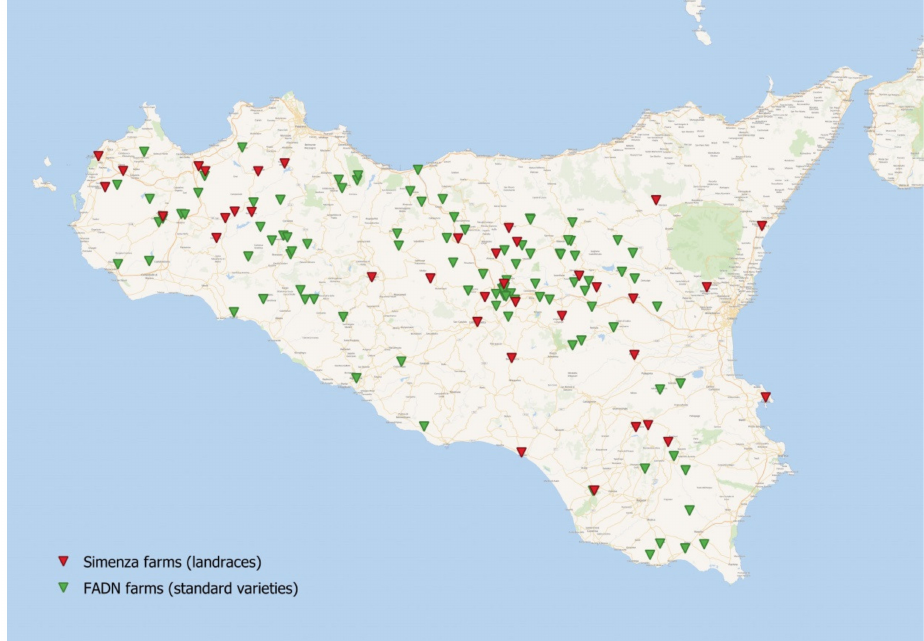
Figure 2. Map of observed farms